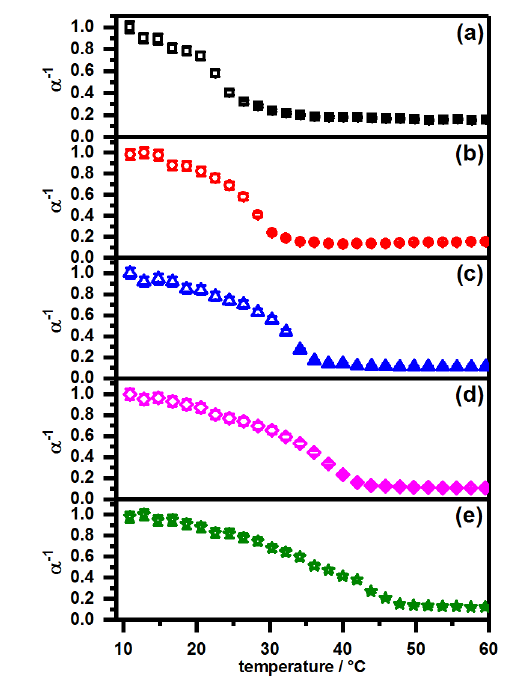
Figure 8. PCS swelling curves of the samples ( a ) PNN100/PMAM0 (black squares); ( b ) PNN75/PMAM25 (red circles); ( c ) PNN50/PMAM50 (blue triangles); ( d ) PNN25/PMAM75 (magenta diamonds) and ( e ) PNN0/PMAM100 (olive stars). All measurements were performed at